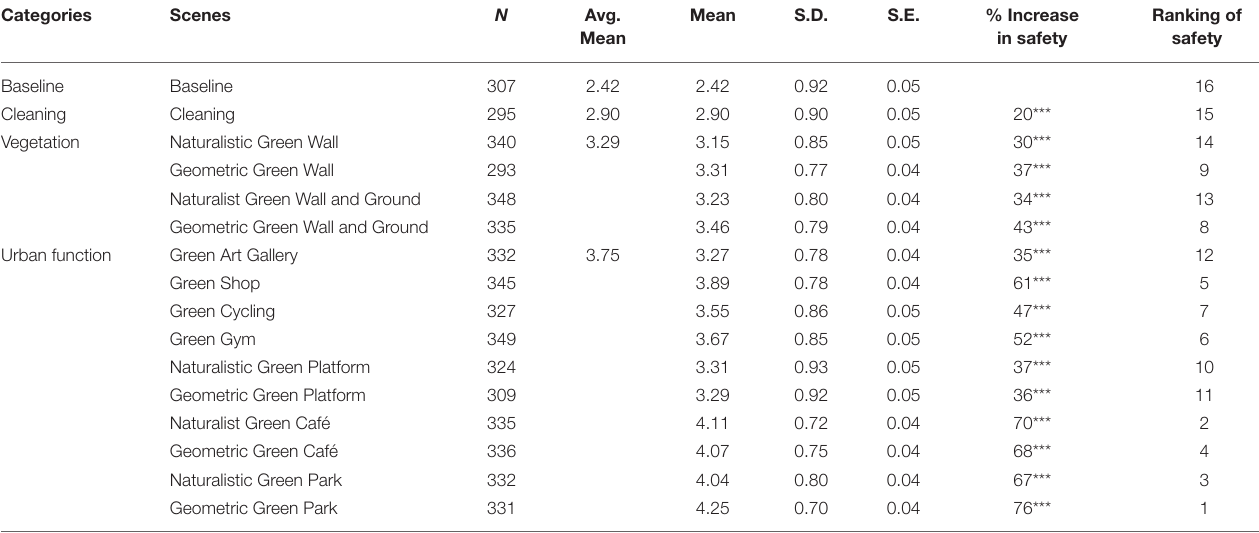
TABLE 2 | Descriptive information of the reported perceived safety for the baseline and 15 interventions and percent increase in perceived safety. Categories